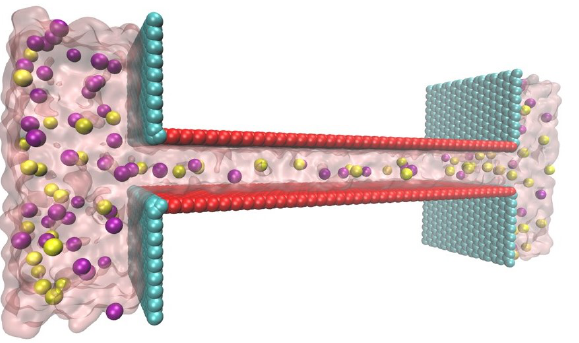
Figure 2. Schematic of the MD simulation structure drawn by VMD [44]. K + and Cl − ions are in purple and yellow, respectively. The charged surface is colored red and the neutral wall is